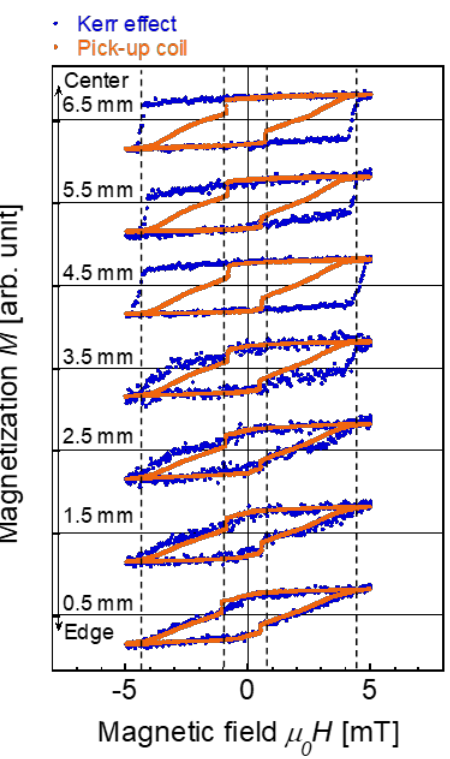
Figure 4. Magnetization curves of the Wiegand wire obtained from the MOKE and the voltage induced in the pick-up coil. The measurement position is varied at L = 0.5–6.5 mm of the wire. The alternating magnetic field of | H ap | = 5 mT/ μ 0 is applied.